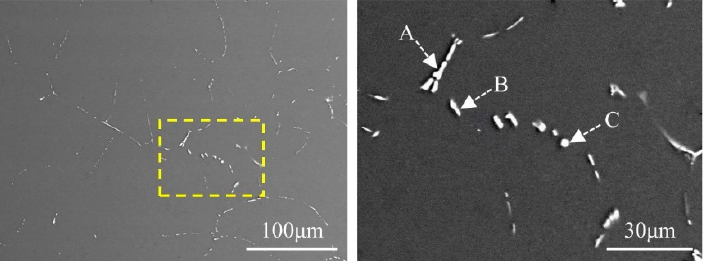
Figure 7. Electron backscattering image of homogenized specimen and energy spectrum dotting position of Table 4. Table 4. Energy spectrum analysis results of precipitated phase (atomic fraction/%).